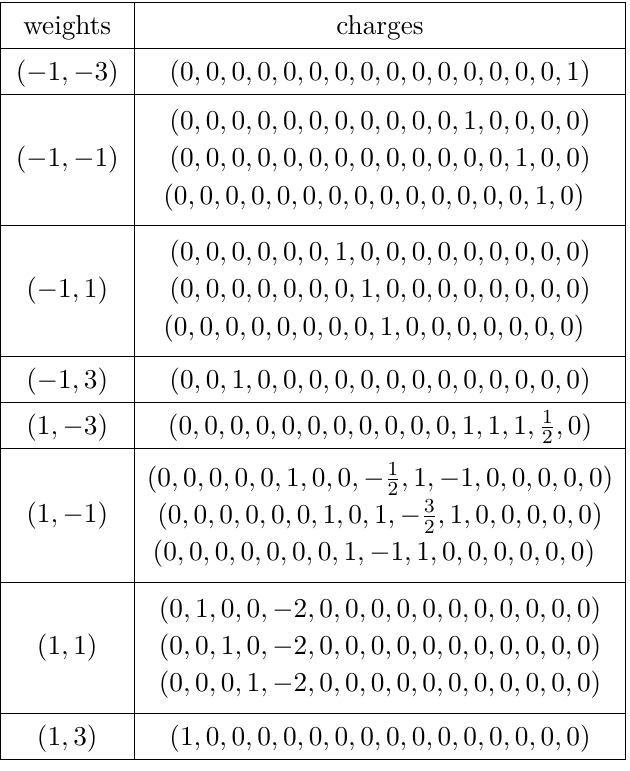
Table 1. Eigenspaces of the weight operators given in (B.1). In order to connect to the scaling of the linear scenario (5.24) we grouped the weights ‘